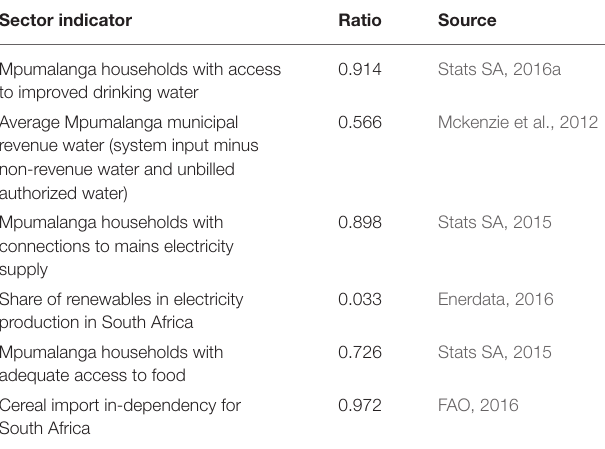
TABLE 2 | Loss of high-value agricultural land due to mining activities in Mpumalanga (ha) ( Collett, 2013).